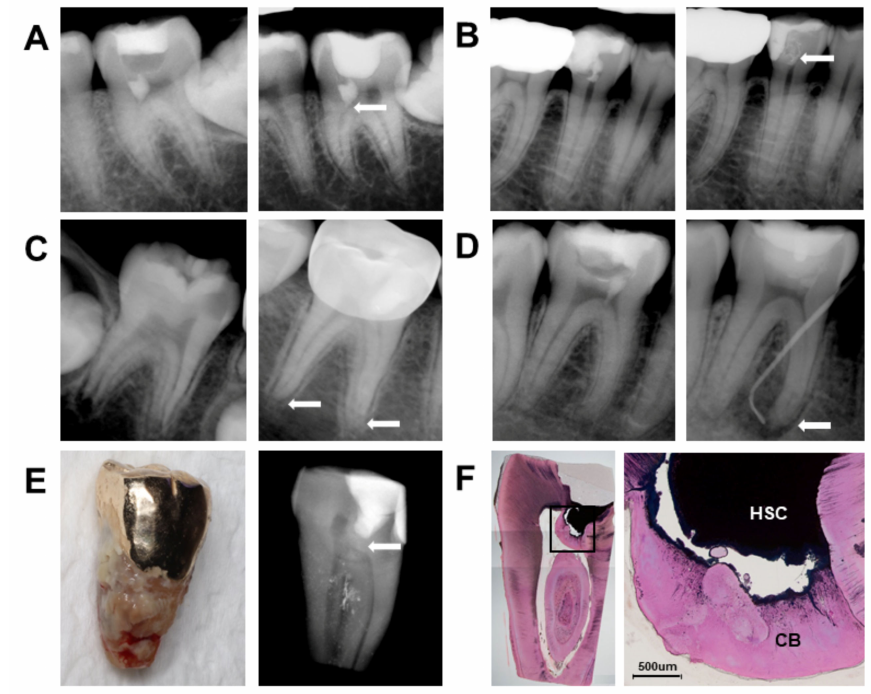
Figure 3. Radiographic and histologic evaluation of partial pulpotomy with three hydraulic silicate cements: ( A ) 17 Y, F, #36, OrthoMTA, 78 months follow-up: Calcific barrier formation (white arrow) with no clinical symptom. ( B ) 29 Y, F, #45, ProRoot MTA, 61 months follow-up; MTA has remarkably washed out (white arrow) with no clinical symptom and thin calcific barrier formation. ( C ) 6 Y, M, #46, OrthoMTA, 64 months follow-up: Apexogenesis is seen (white arrow). ( D ) 22 Y, M, #46, RetroMTA, 59 months follow-up: Increased periapical radiolucency with sinus tract formation (white arrow). ( E ) 49 Y, M, #37, ProRoot MTA, 78 months follow-up: Extracted tooth due to advanced periodontitis. The radiograph shows a thick calcific barrier formed without canal calcification (white arrow). ( F ) A histologic image of ( E )—low magnification (left) and high magnification (right, 40 × ) images shows continuous calcific barrier under HSC. HSC: hydraulic silicate cement; CB: calcific